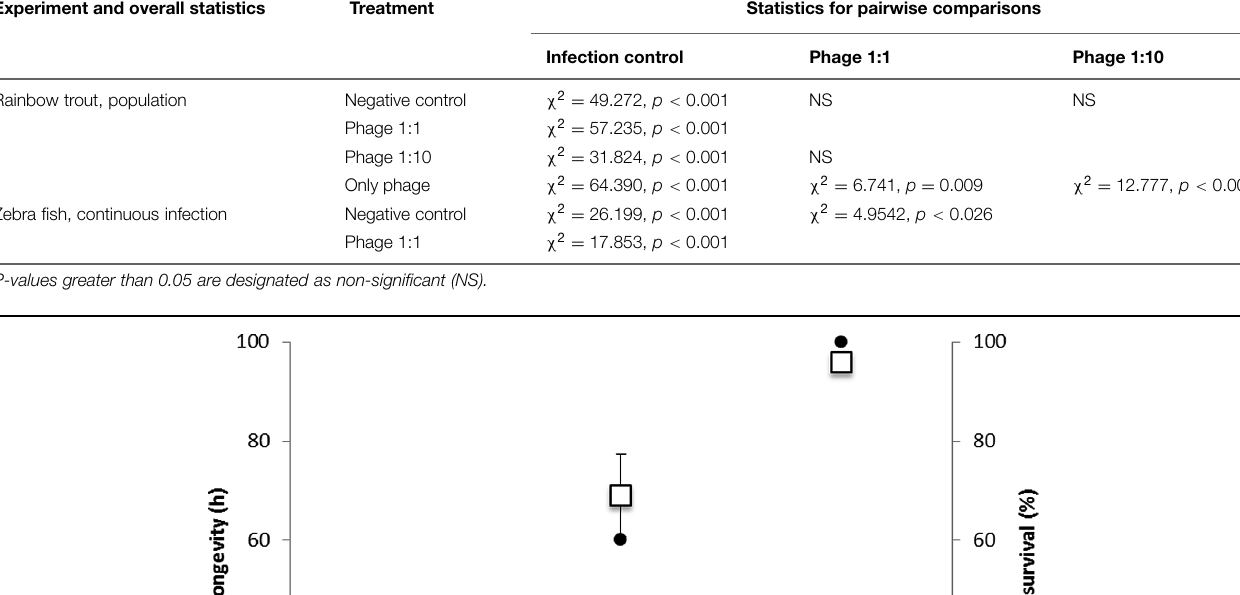
TABLE 2 | Statistics of pairwise comparisons in fish survival in phage therapy experiments against Flavobacterium columnare in rainbow trout ( Oncorhynchus mykiss ) and zebrafish ( Danio rerio ) using Kaplan–Meier survival analysis, pairwise log rank Mantel Cox test. Experiment and overall statistics